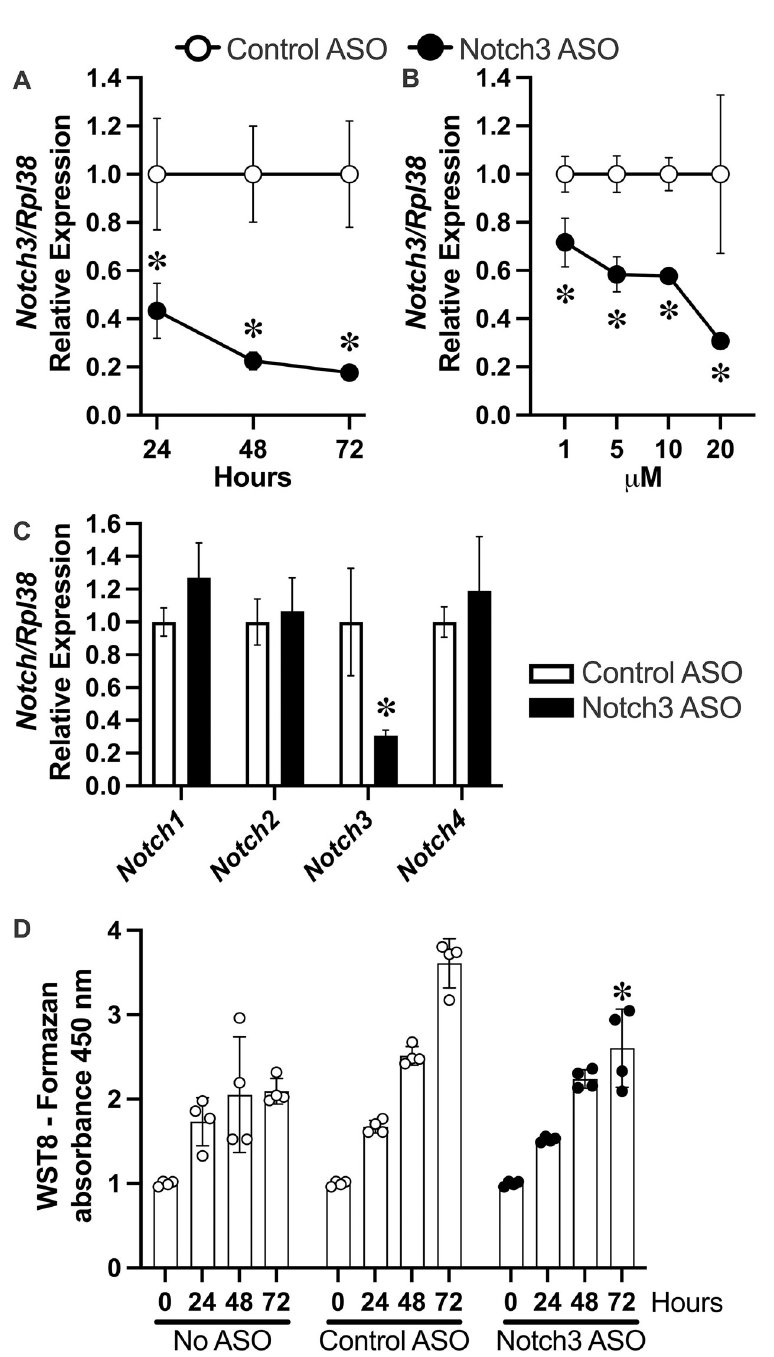
Fig 1. Effect of control or Notch3 ASOs on Notch3 mRNA expression and cell replication in calvarial osteoblast- enriched cells. In panels A and B, Notch3 mRNA levels were obtained 24 to 72 h (panel A) or 72 h (panel B) after the addition of Notch3 (closed circles) or control ASOs (open circles) at 20 μ M in panel A or at 1 to 20 μ M in panel B to cells from wild type C57BL/6 mice. In panel C, Notch1 , 2 , 3 and 4 mRNA levels were obtained 72 h after the addition of Notch3 (black bars) or control ASO (white bars) at 20 μ M to cells from wild type C57BL/6 mice. Transcript levels are expressed as relative number following correction for Rpl38 . Values are means ± SD; n = 3 technical replicates. In panel D, osteoblasts were cultured for 0 to 72 h in the absence or presence of control or Notch3 ASOs at 20 μ M and viable cells determined by cell counting kit 8 assay and data expressed as formazan dye and measured at an absorbance of 450 nm. Data are means ± SD; n = 4 technical replicates. � Significantly different between Notch3 ASO and control ASO, p < 0.05.